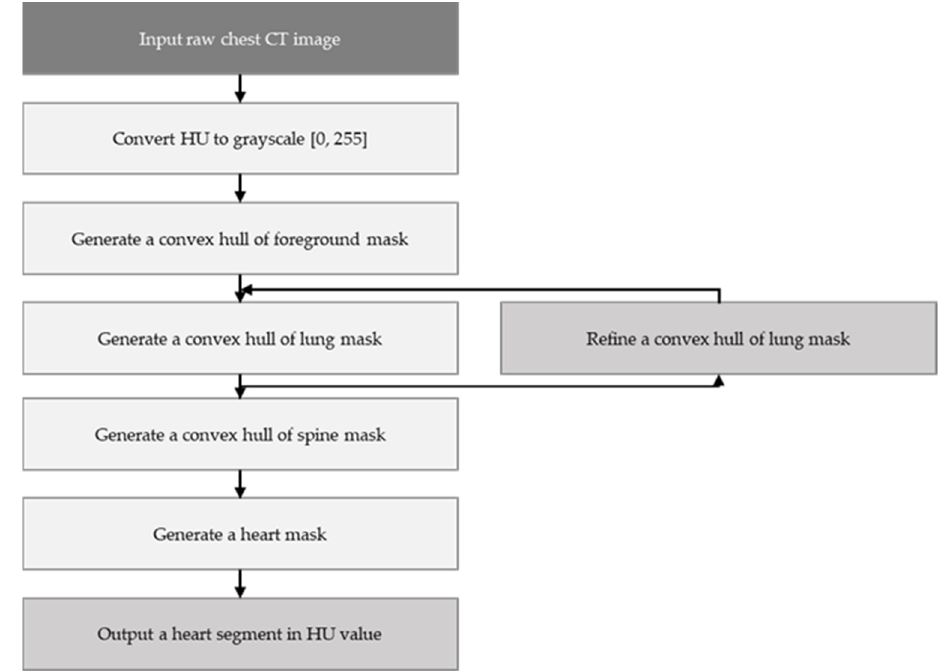
Figure 6. Flowchart for the cardiac region segmentation process.